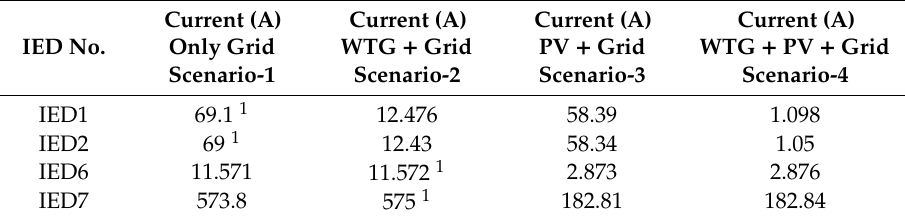
Table 2. Normal RMS (Root mean square) currents at considered intelligent electronic device (IED) locations with four di ff erent distributed generator (DG) scenarios in grid-connected mode. WTG: wind turbine generators and PV: photovoltaic.